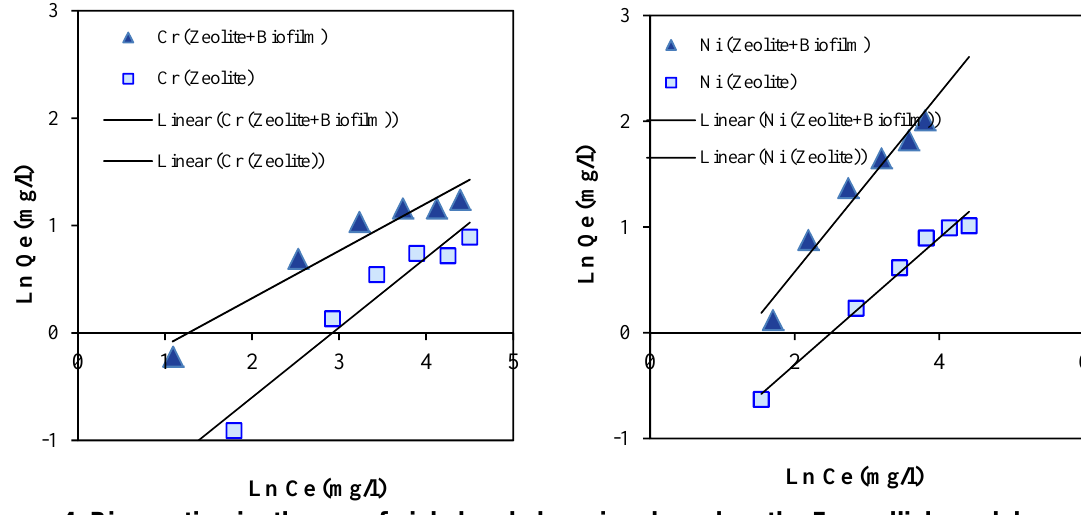
Figure 4. Biosorption isotherms of nickel and chromium based on the Freundlich model Table 2. Parameters of Langmuir and Freundlich isotherms for biosorption of Ni and Cr Type of